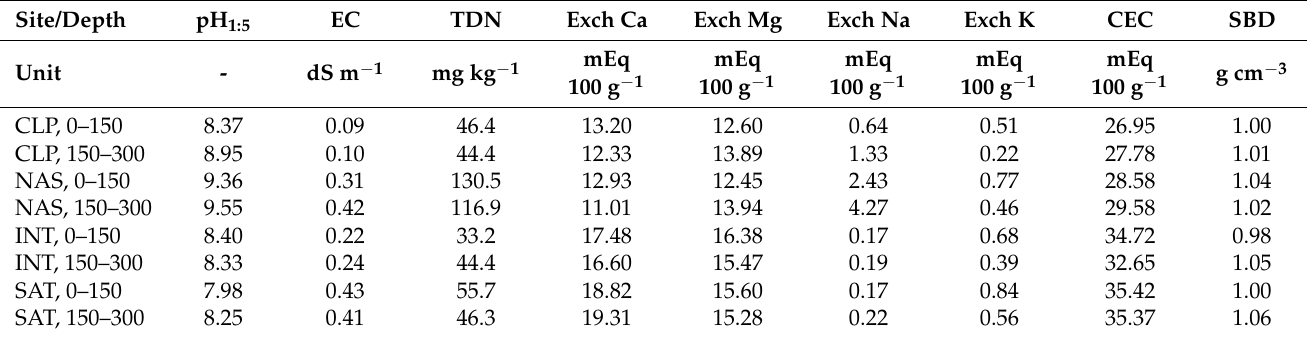
Table 1. Characterization of soil in four cotton fields, sampled from two depths (0–150 mm and 150–300 mm). CLP and NAS were sampled in October 2016, INT and SAT were sampled in November 2017. TDN is total dissolved N and SBD is soil bulk density. Exchangeable (Exch) cations were extracted after pre-treatment for soluble